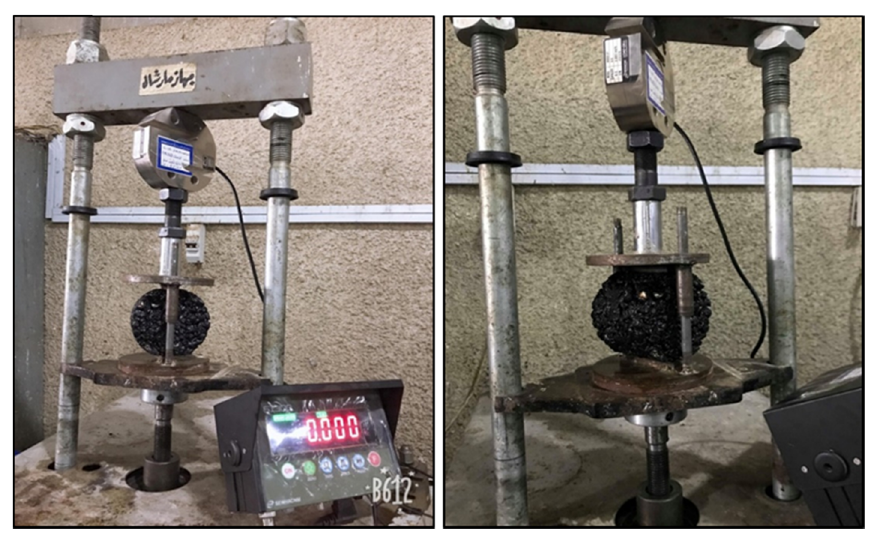
Figure 5: The indirect tensile test by Marshall